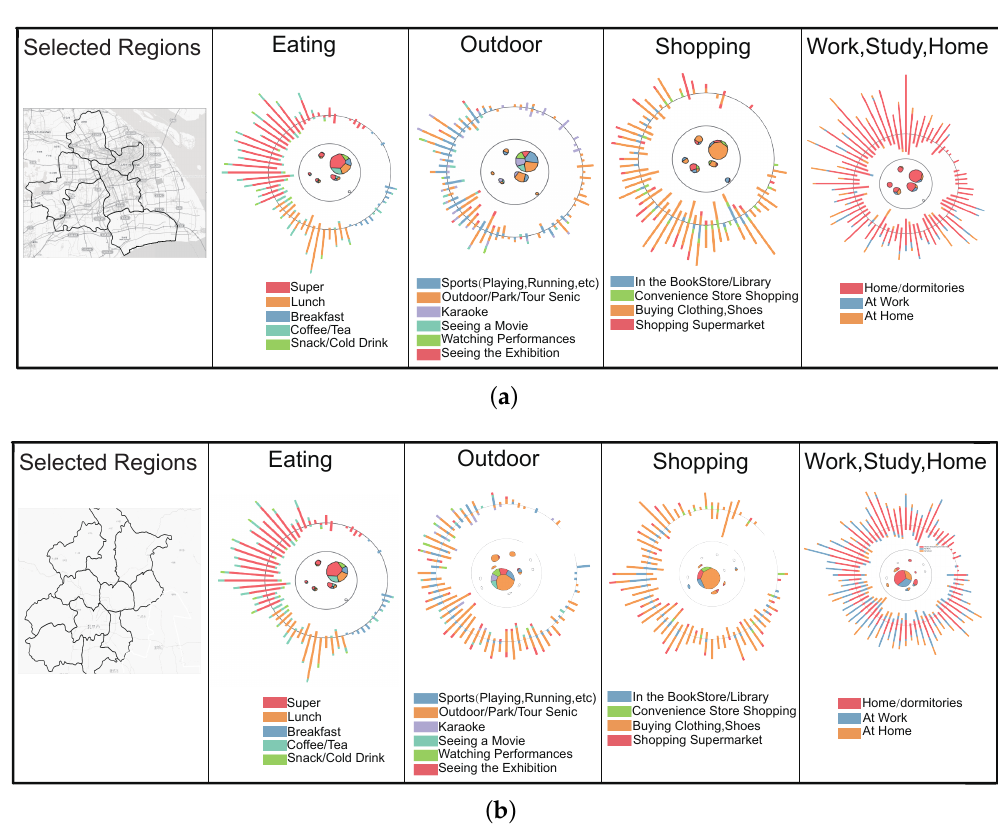
Figure 10. Case 3. The comparison between two user groups shows different spatial, temporal, and activity behaviors. ( a ) User group fingerprinting in Shanghai; ( b ) User group fingerprinting in Beijing.